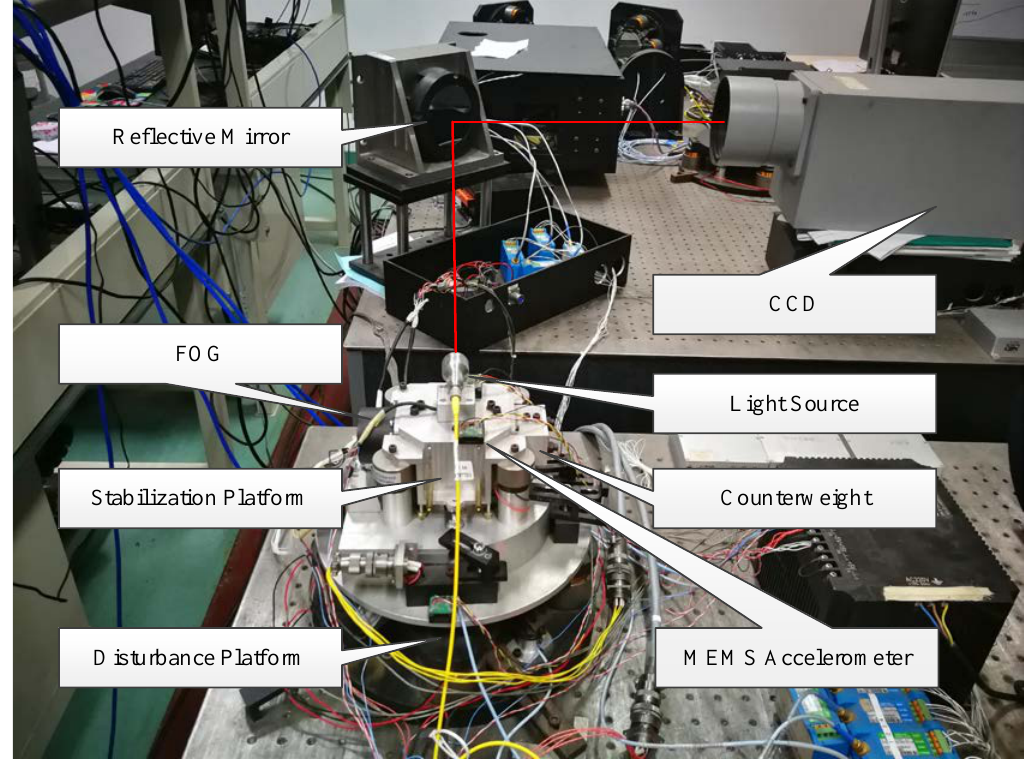
Figure 7. The experimental devices.